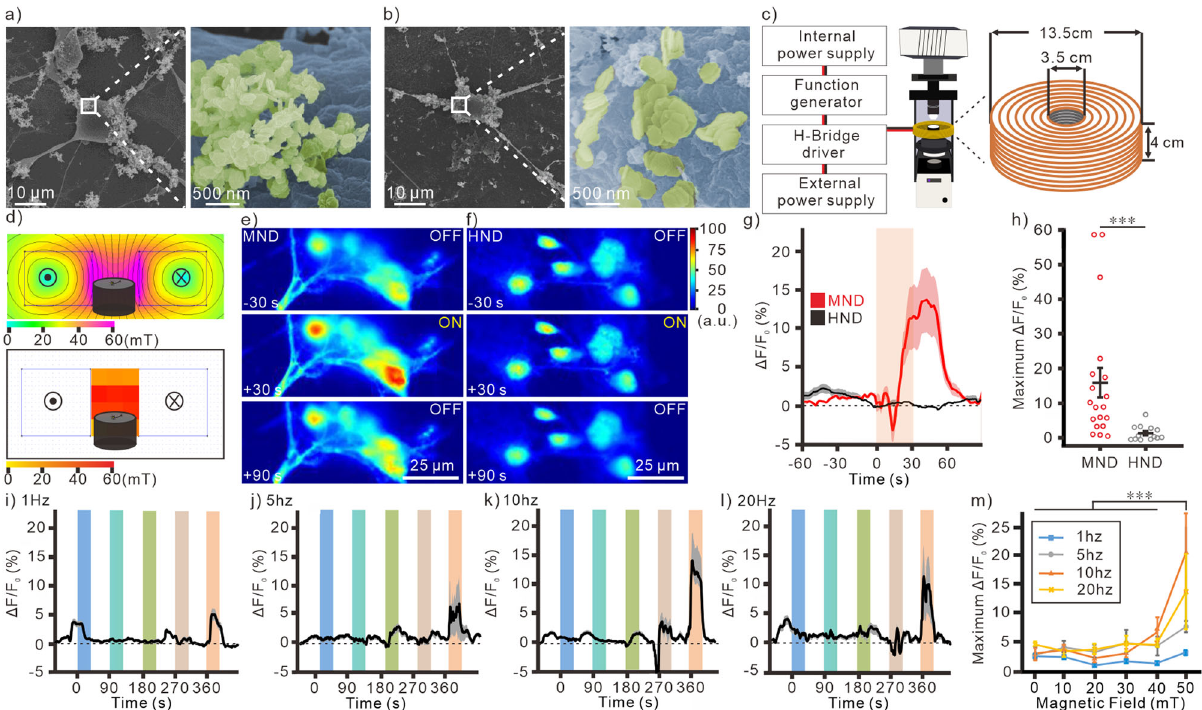
Fig. 2 MND-mediated neuronal responses by magnetomechanical stimulation. SEM images of MNDs ( a ) and HNDs ( b ) on the membrane of cultured neurons. c Schematic of magnetic apparatus for fl uorescence microscope. right, the dimension of the custom-made coil. d Heat maps of magnetic fi elds generated by coil. top, FEMM simulation of the coil with 3 A current. bottom, the measured magnetic fi eld inside of the coil with 3 A DC current. Color maps of fl uorescence intensity of neurons with MNDs ( e ) or HNDs ( f ) application. Magnetic fi eld with 50 mT at 10 Hz was applied for 30 s. g Average traces of Ca 2 + responses by magnetic fi eld stimulation. Red line, MND group ( n = 19/3 (neurons/samples)); Black line, HND group ( n = 13/3); Light area, s.e.m. h Maximum change of Ca 2 + responses in different groups (MND, n = 19/3 (neurons/samples); HND, n = 13/3). *** p < 0.001, Mann-Whitney test. The averaged traces of magnetic induced neuronal Ca 2 + responses which were stimulated by different frequencies at 1 Hz ( i , n = 46/6 (neurons/ samples)), 5 Hz ( j , n = 30/6), 10 Hz ( k , n = 19/6), or 20 Hz ( l , n = 18/6). In each frequency, magnetic fi eld intensity was sequentially increased from 10 to 50 mT. The gray areas are s.e.m. The color areas indicate the time periods of magnetic stimulation at 10 (blue), 20 (cyan), 30 (green), 40 (pink), and 50 mT (orange). m The maximum Δ F/F 0 at different conditions (1 Hz, n = 46/6 (neurons/samples)); 5 Hz, n = 30/6; 10 Hz, n = 19/6; 20 Hz, n = 18/6. F = 9.639, p < 0.001 for fi eld intensity, F = 6.155, p < 0.001 for frequencies; F = 1.459, p = 0.11 for interaction of frequencies and intensities.